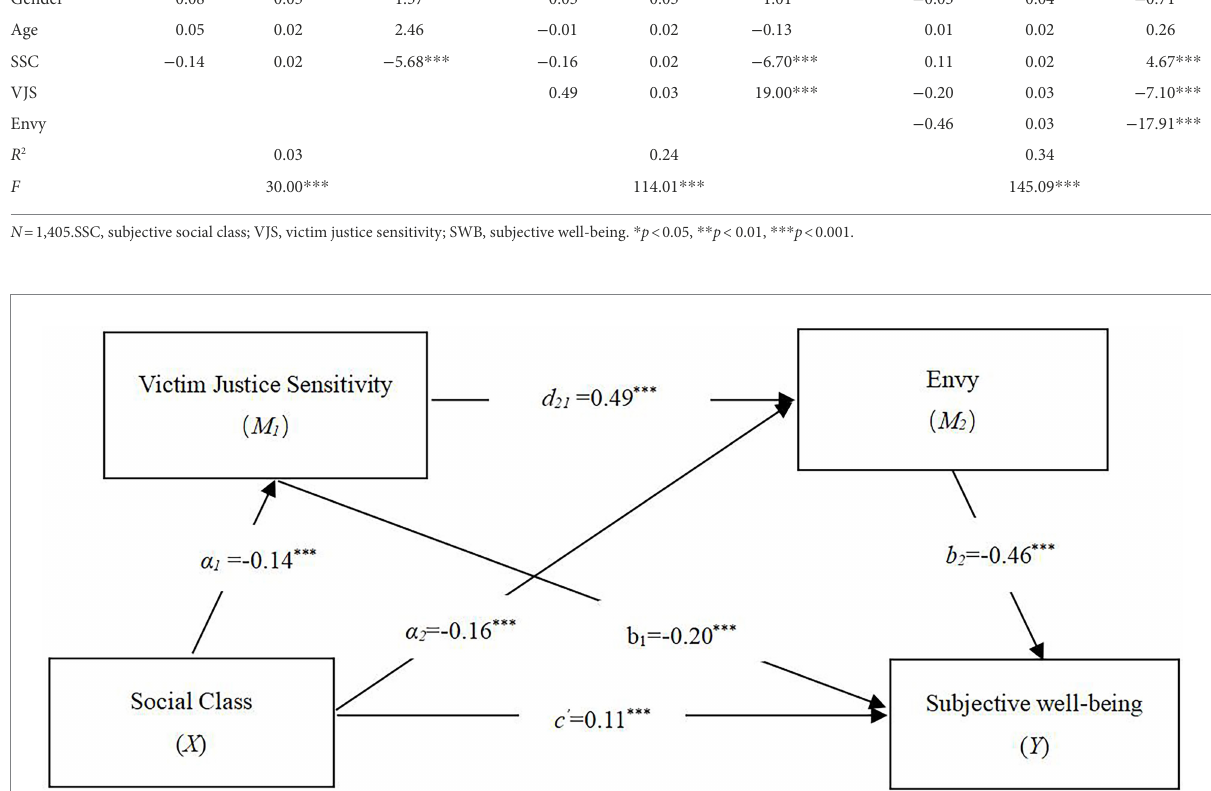
Model 2, with envy as the dependent variable, social class negatively influenced envy ( β = − 0.16, p < 0.001).